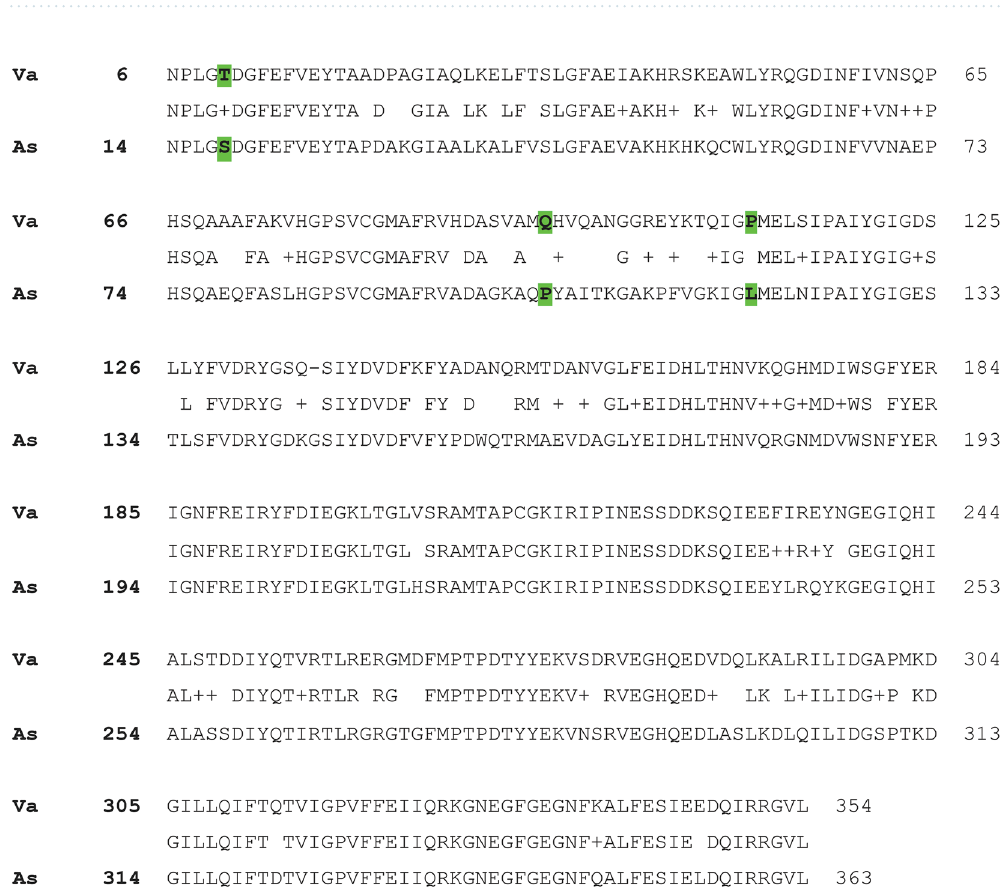
Figure 5. 4-Hydroxyphenylpyruvate-dioxygenase amino acid sequences comparison. Alignment of the amino acid sequences of the 4-hydroxyphenylpyruvate-dioxygenase proteins from V . anguillarum (Va) and A . salmonicida (As) (accession number MH909233.1). Amino acids involved in thermolability are highlighted in